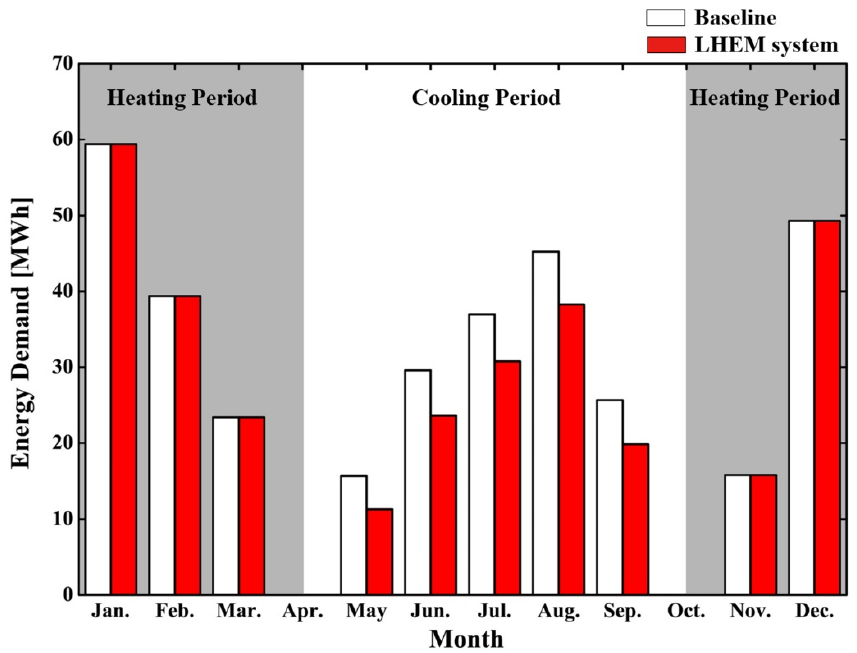
Figure 8. Heating and cooling energy demand for the model office building with and without the LHEM